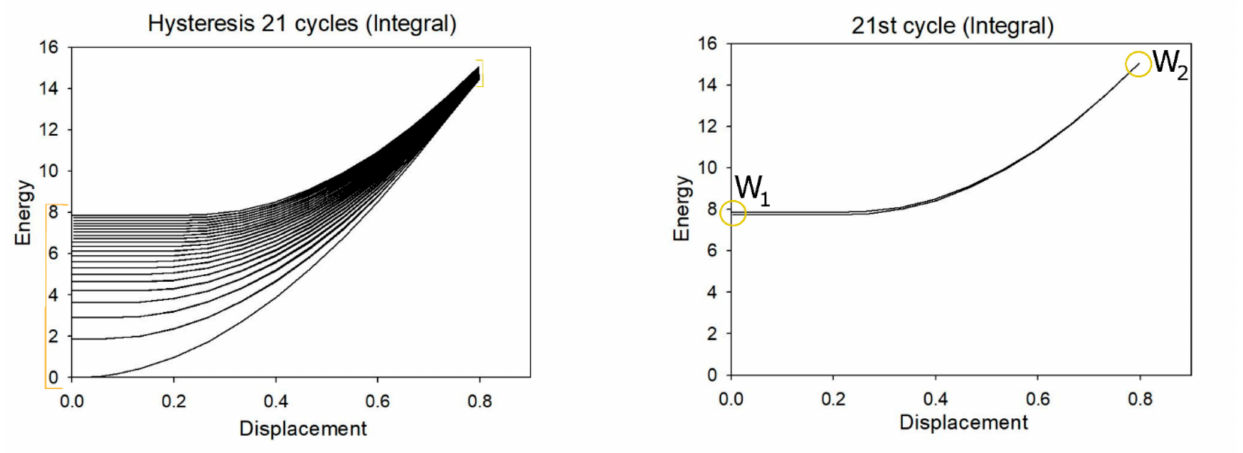
Figure 6. Schematic of numerical calculation of absorbed